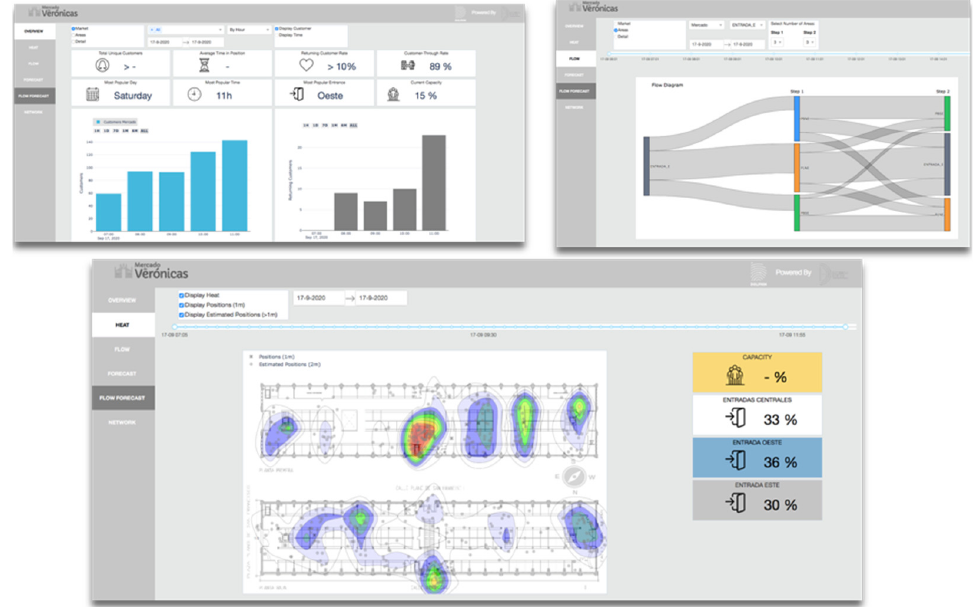
Figure 6. Graphical interface for the user showing the KPI of one day during the real deployment in an indoor environment. Upper left: overview panel of the developed EWS platform; Upper right: people flows, starting from the entrance of the building and showing two levels of depth, first the top three visited locations from the entrance (i.e., where do people go once has entered the building?), and second, the next top three visited locations from the previous three places; Lower center: heatmap with people density in the two floors of the monitored area.